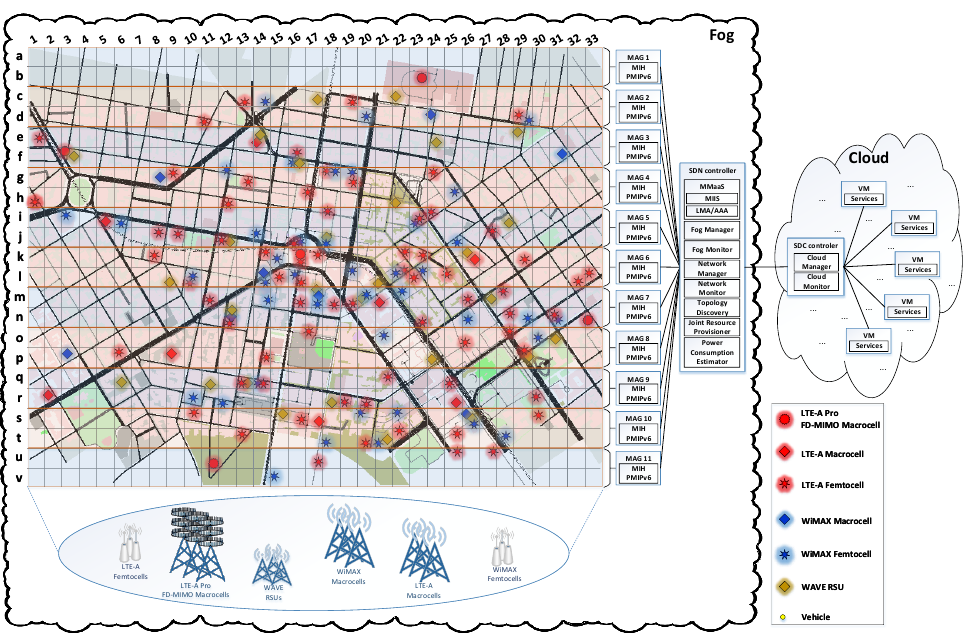
Figure 13. The simulated